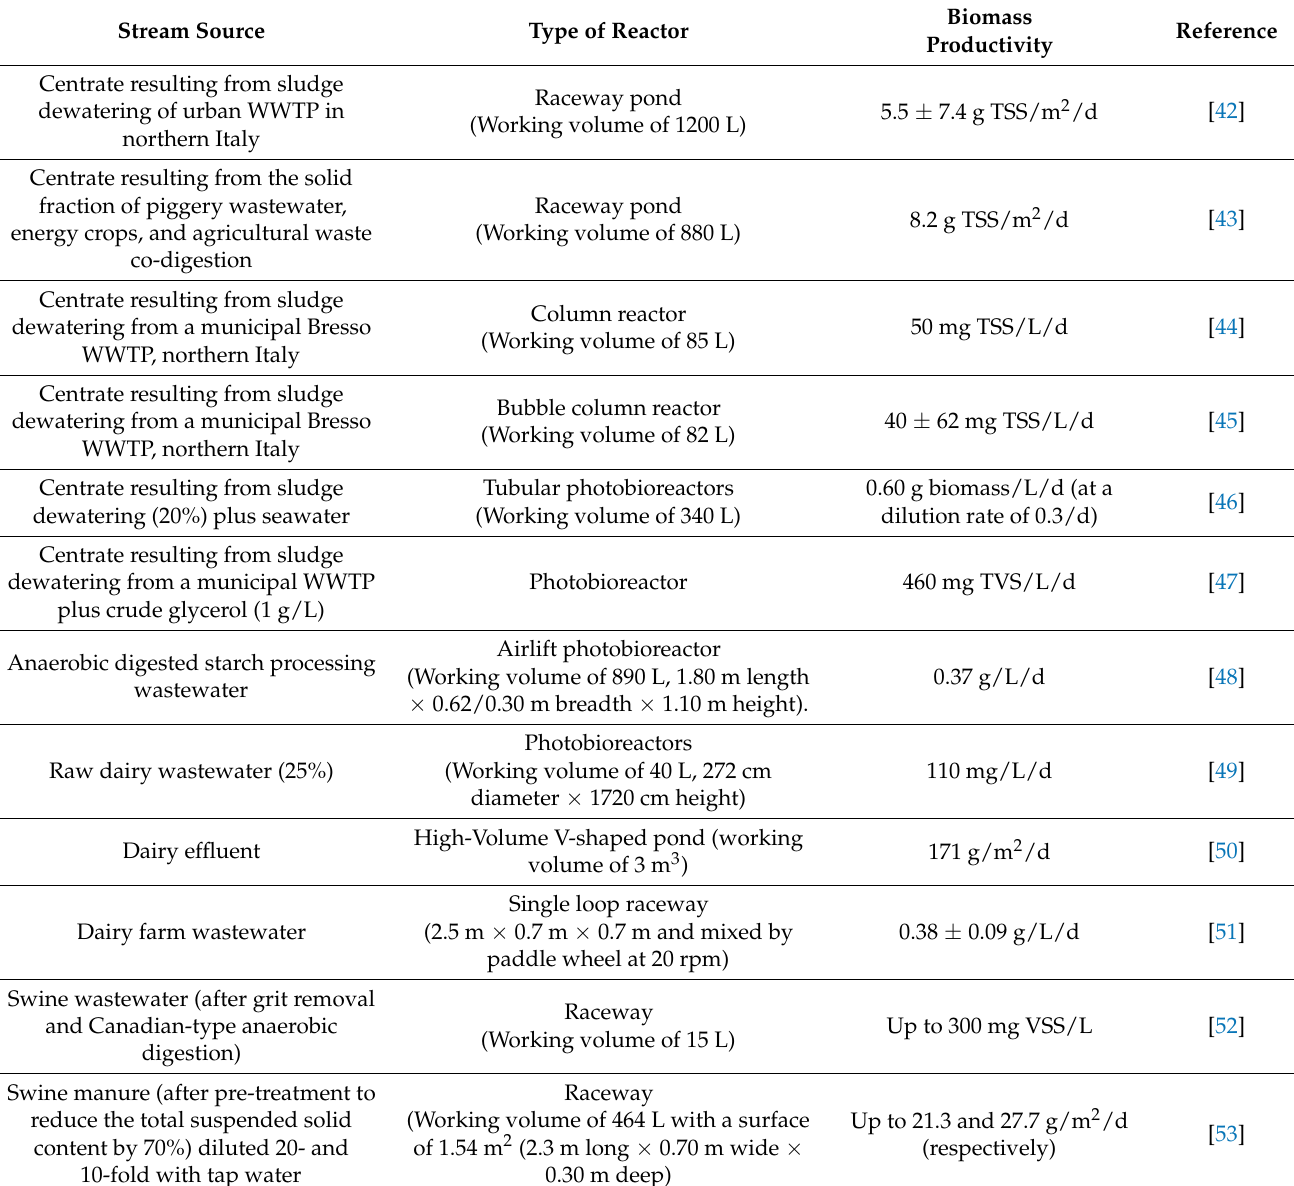
Table 4. Microalgae culturing in wastewater streams in pilot-scale